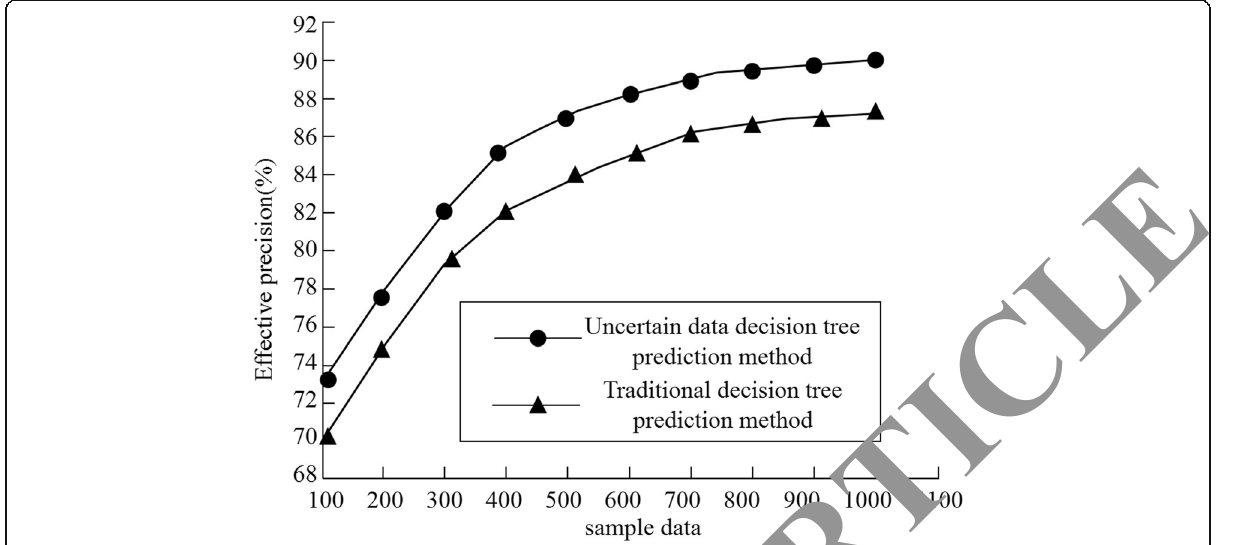
Fig. 5 Comparison of the effective accuracy of the two decision tree algorithms